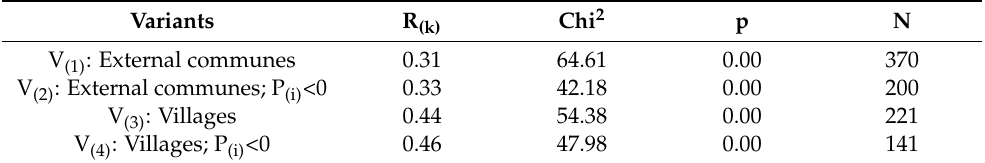
Table 1. Canonical analysis between budget transfers and urban sprawl.